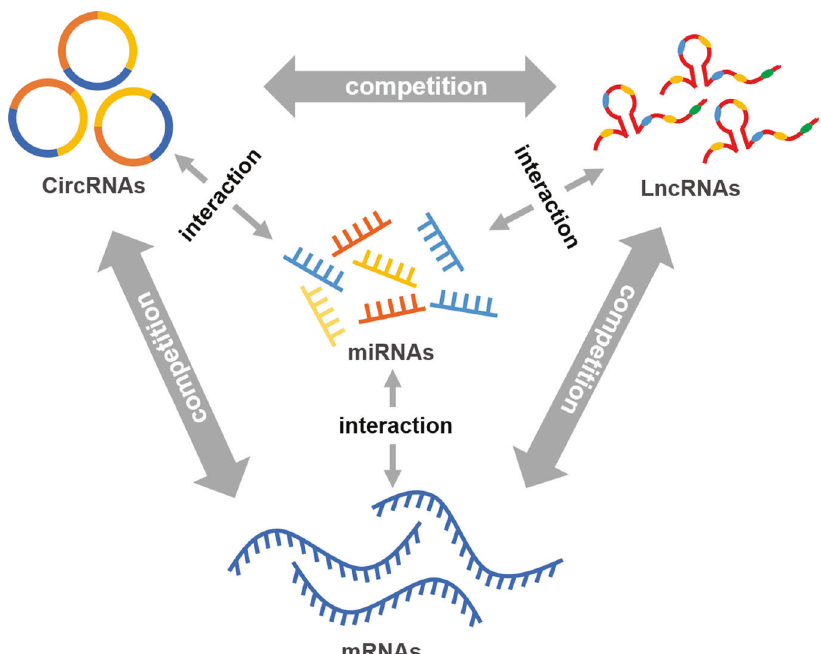
Fig. 1 The overview of the ceRNA